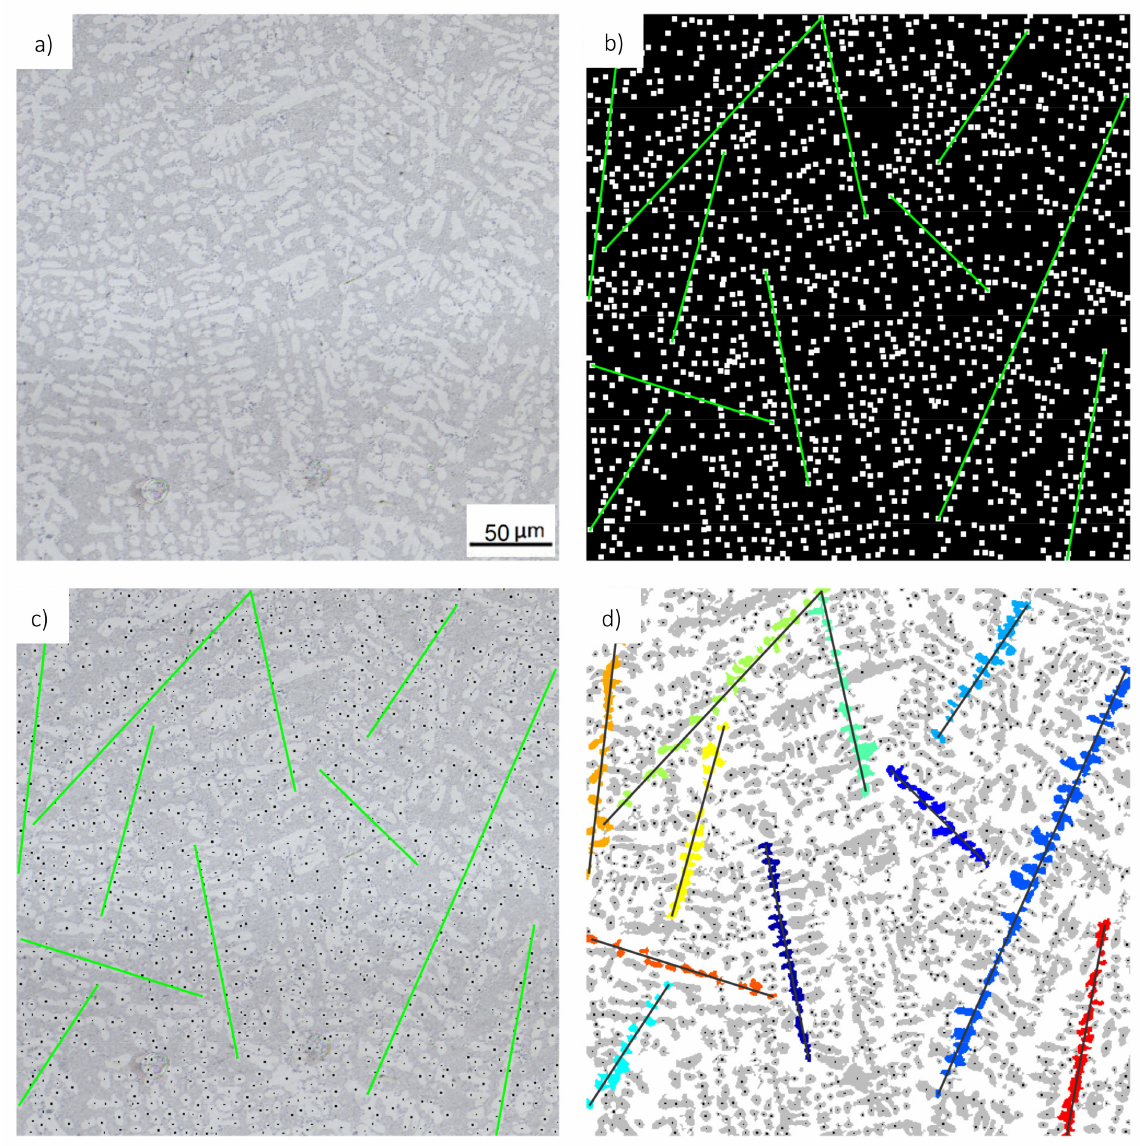
Figure 3. Segment clustering through Hough transform; ( a ) original micrograph; ( b ) dilated centroid mask (black/white) with a selection of detected lines (green); ( c ) line selection within the original micrograph together with the segment- centroids; ( d ) clustering of segments that intersect with a detected